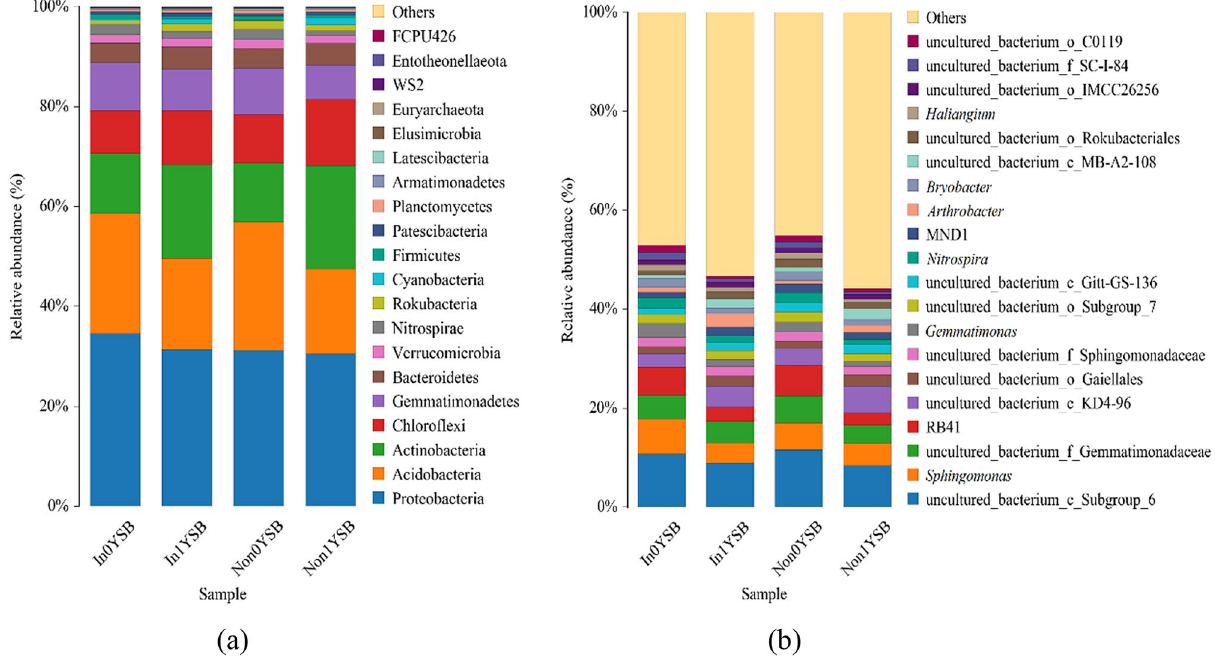
Figure 3. The composition of bacterial communities at the phylum ( a ) and genus ( b ) levels. Non represents non-inoculated with R. intraradices . In represents inoculated with R. intraradices . 0Y and 1Y represent 0 year and 1 year of continuous cropping, respectively. SB represents bacteria in rhizosphere